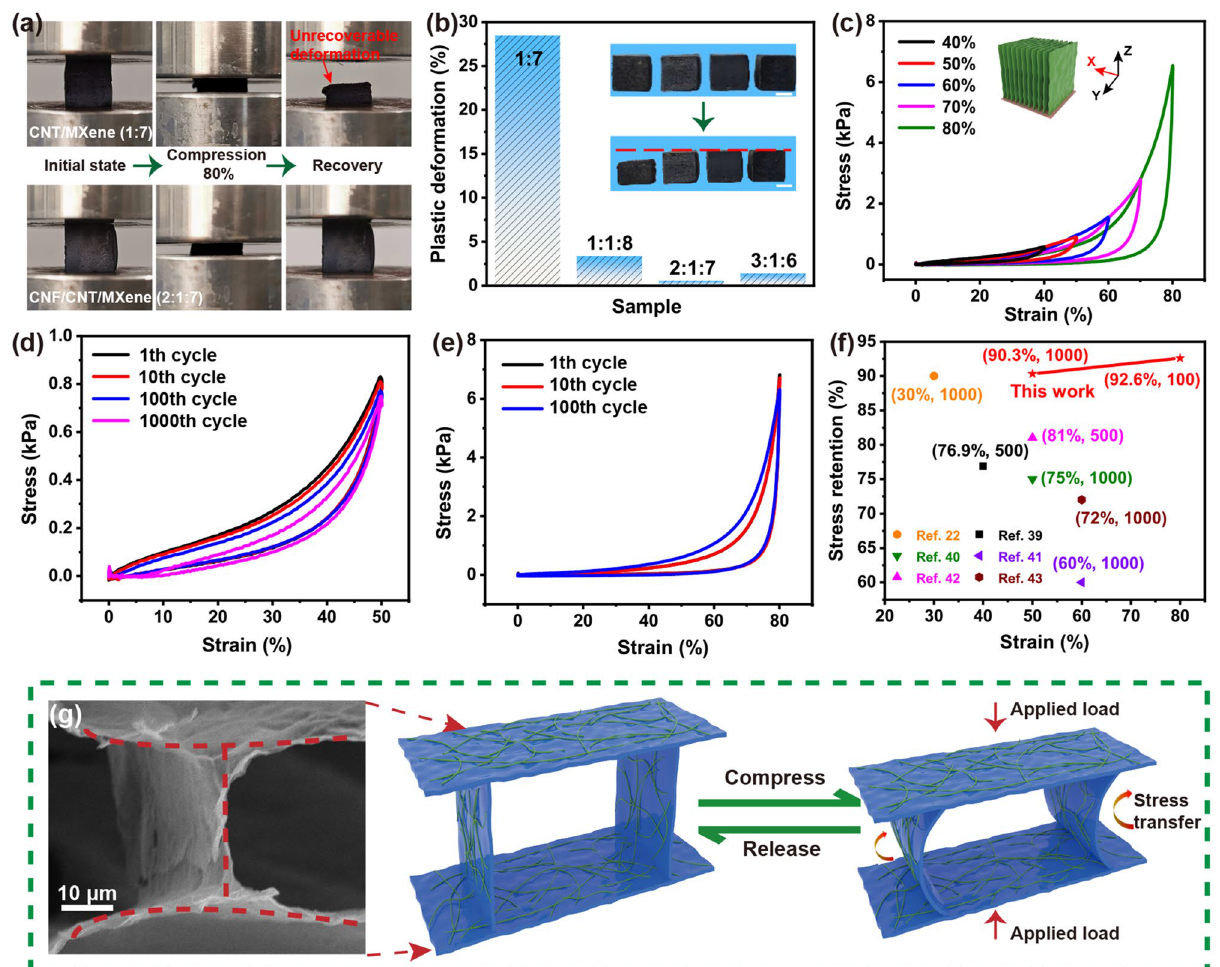
Fig. 3 a Experimental photographs for the first compression cycle of CNT/MXene (1:7) and CNF/CNT/MXene (2:1:7) aerogels. b Histograms of irreversible deformation percentages after the first cycle. The inset shows the height contrast photos of samples after the first cycle (the scale bar is 1 cm). c Stress–strain curves of CNF/CNT/MXene (2:1:7) aerogel at 40%–80% compression strains in X-direction (the inset shows the direction of compression). Stress–strain curves d at 50% strain for 1000 cycles and e at 80% strain for 100 cycles. f Comparison of the stress retention of CNF/CNT/MXene (2:1:7) aerogel with those of MXene- and carbon-based aerogels. g Mechanism illustration of the compressive deformation of the CNF/CNT/MXene (2:1:7)